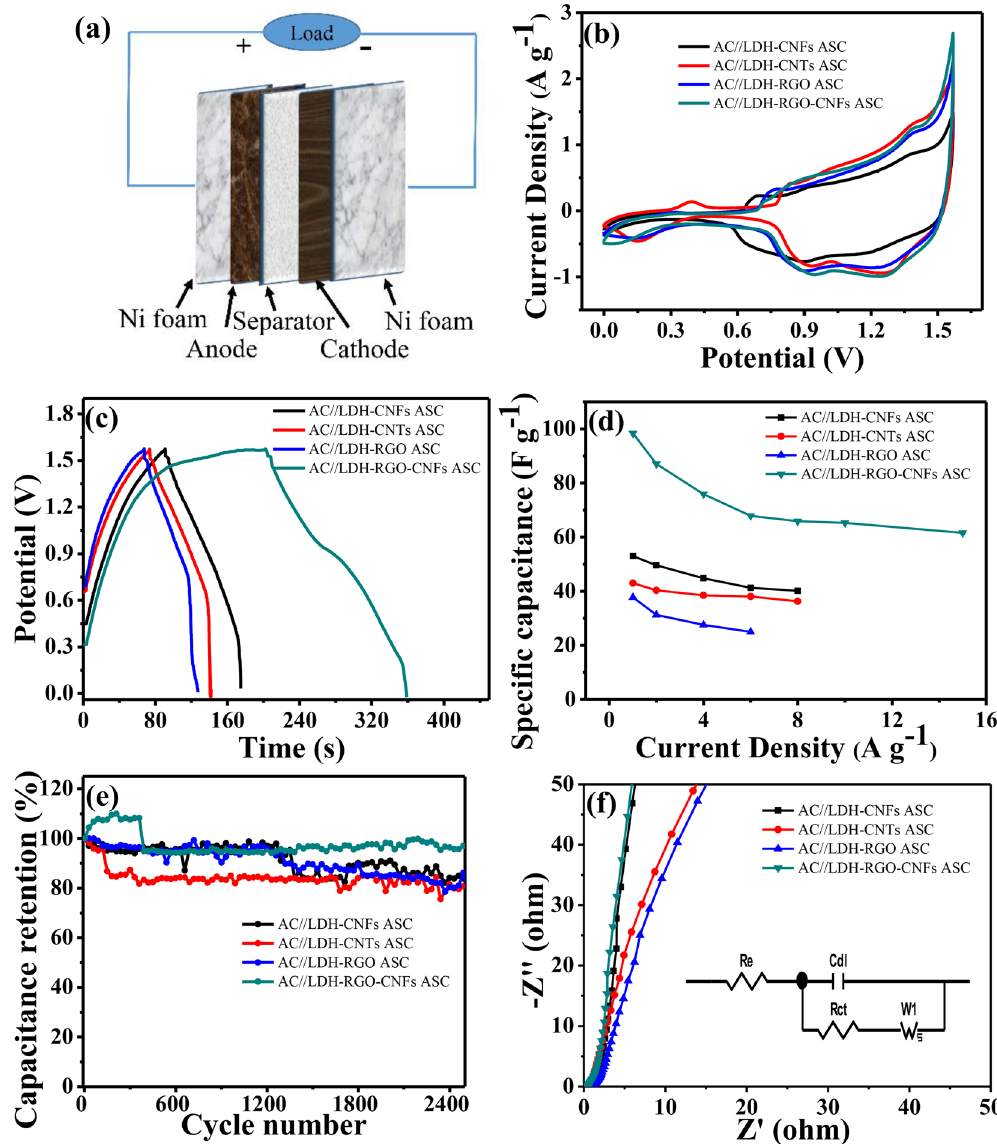
Figure 6. ( a ) The schematic of the ASC. Electrochemical capacitive properties of AC//LDH-CNFs ASC, AC// LDH-CNTs ASC, AC//LDH-RGO ASC and AC//LDH-RGO-CNFs ASC. ( b ) CV curves at 10 mV s − 1 . ( c ) GCD curves at 1 A g − 1 . ( d ) The specific capacitance at different current densities. ( e ) The specific capacitance retention with 2500 cycling numbers for the AC//LDH-CNFs ASC, AC//LDH-CNTs ASC and AC//LDH-RGO- CNFs ASC at 8 A g − 1 and AC//LDH-RGO ASC at 6 A g − 1 . ( f ) The Nyquist plots measured in a frequency range between 0.01 and 10 5 Hz. Inset: simplified equivalent